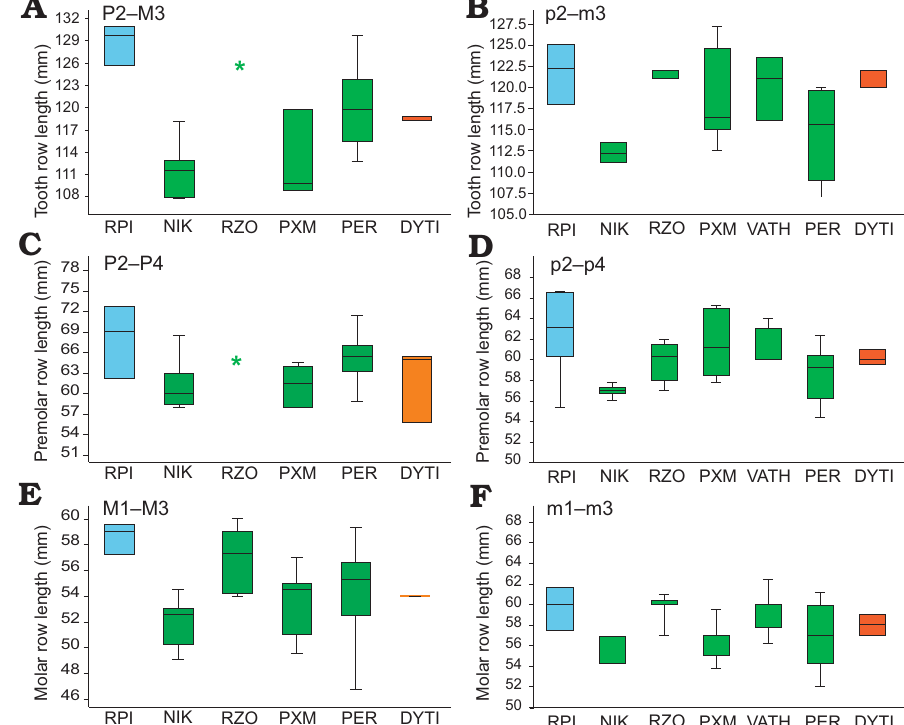
Fig. 11. Box-plot diagrams comparing the length of the upper and lower tooth row ( A , B ), premolar row ( C , D ), and molar row ( E , F ) of Hipparion macedonicum from the various Greek